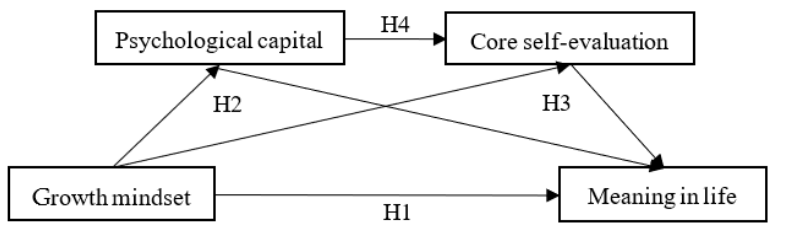
Figure 1. Theoretical research model.